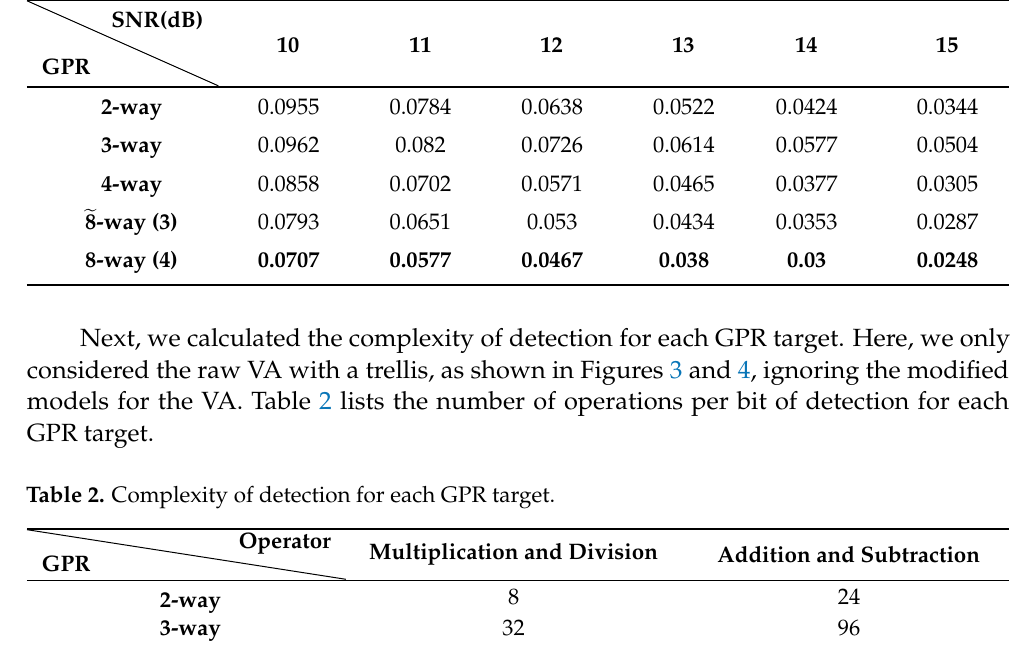
Table 1. MMSE results according to the signal-to-noise ratio (SNR).